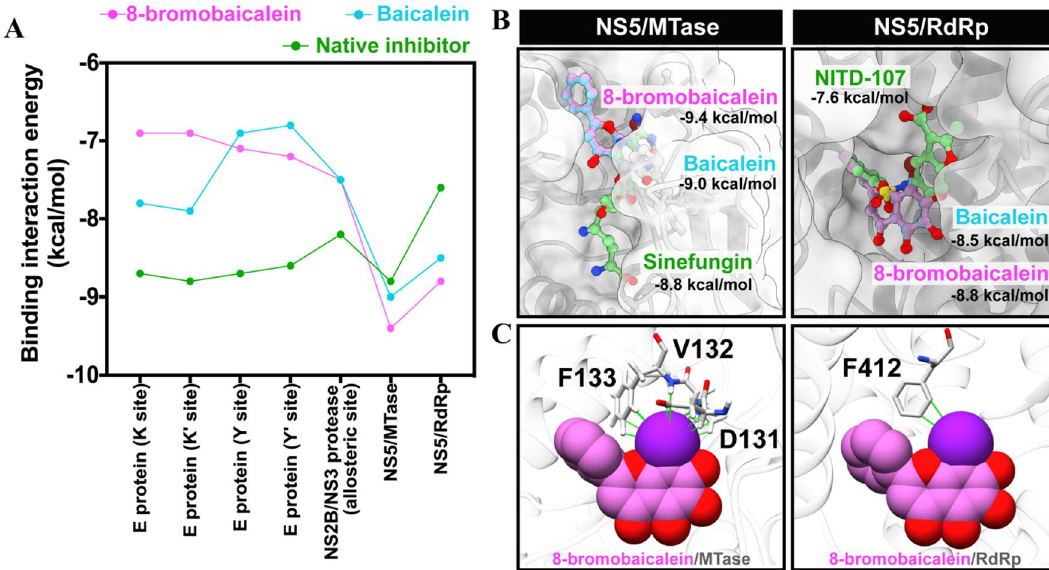
Figure 2. ( A ) Binding interaction energy (kcal/mol) of baicaleins with the four targets relative to known inhibitors. ( B ) Ligand conformation and ( C ) halogen interaction at the MTase and RdRp binding